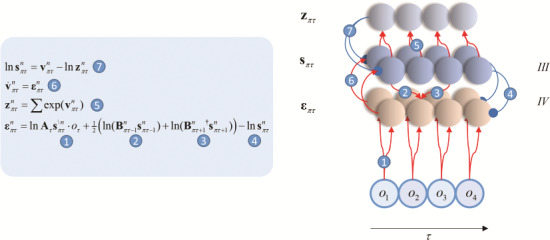
Intrinsic connectivity and neuronal message passing. The equations on the left show the form of the variational message passing mandated by active inference. On the right, we represent these in the form of a neuronal network. Blue connections are inhibitory, and red are excitatory. The input layer is labeled layer IV for consistency with patterns of laminar connectivity in the cortex (Zeki and Shipp 1988; Felleman and Van Essen 1991; Shipp 2007). Layer III houses the cells representing the sufficient statistics of posterior beliefs. It is these that are connected through di-synaptic recurrent excitatory connections and lateral inhibitory connections. The notation \documentclass[12pt]{minimal}
\usepackage{amsmath}
\usepackage{wasysym}
\usepackage{amsfonts}
\usepackage{amssymb}
\usepackage{amsbsy}
\usepackage{upgreek}
\usepackage{mathrsfs}
\setlength{\oddsidemargin}{-69pt}
\begin{document}
}{}${\mathbf{s}}_{\pi \tau}^n$\end{document} means the expected hidden state factor n at time τ, conditioned on a policy. The quantity z is a normalizing constant (or partition function), while v and ε are auxiliary variables that play the roles of membrane depolarization and prediction error, respectively. The network illustrated here is supposed to show how populations of neurons interact with one another to perform variational inference. This implies a representation of beliefs in terms of population averages (or other population codes). While we have shown excitatory and inhibitory connections arising from the same populations, this is not intended to imply a violation of Dale’s law, but instead implies intermediate inhibitory interneurons (that are omitted for clarity).